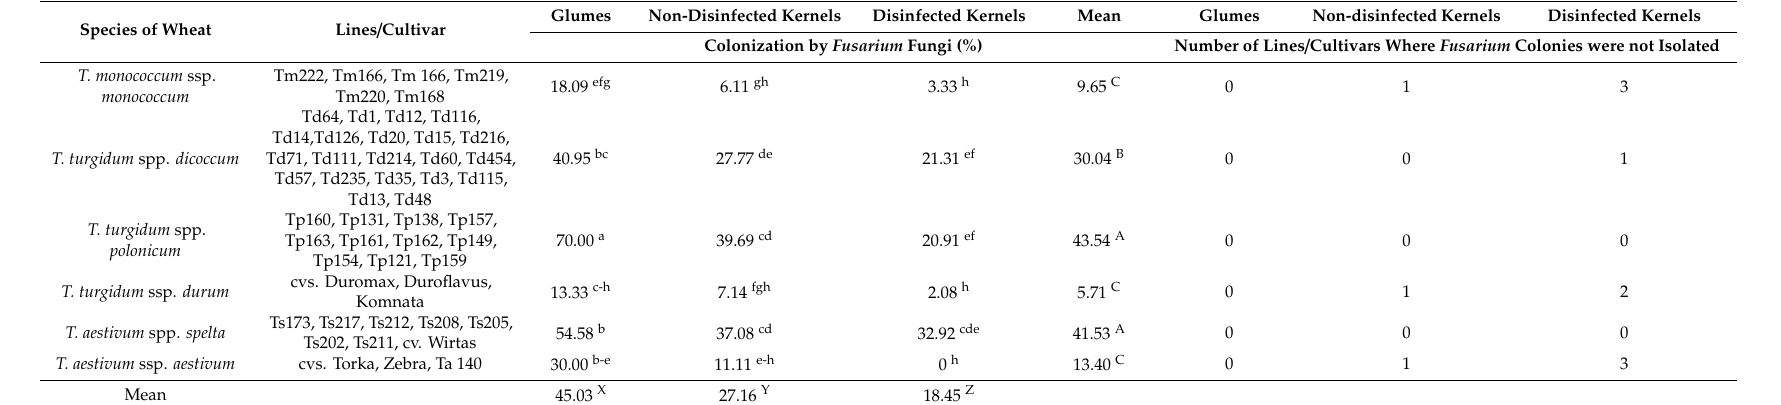
Table 3. The origin and percentage of glumes and kernels colonized by Fusarium